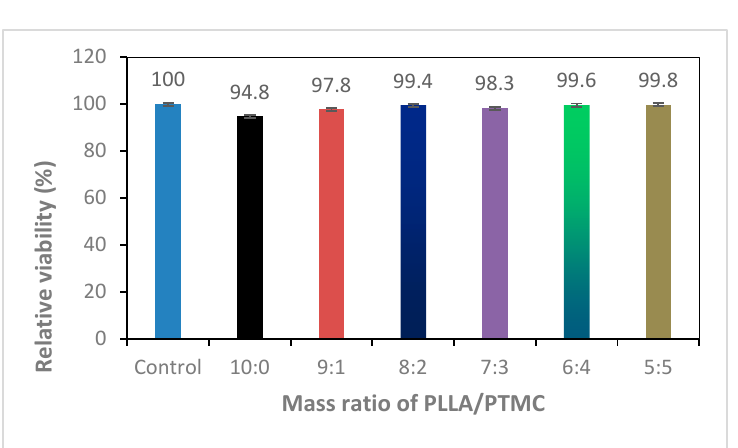
Figure 7. Bar diagram of the cytotoxicity tests conducted using PLLA/PTMC electrospun fibre membrane materials. p < 0.01 with respect to Control, 10:0, 8:2 and 7:3; p < 0.05 with respect to 9:1, 6:4 and 5:5; error bars indicate SD; n = 3.